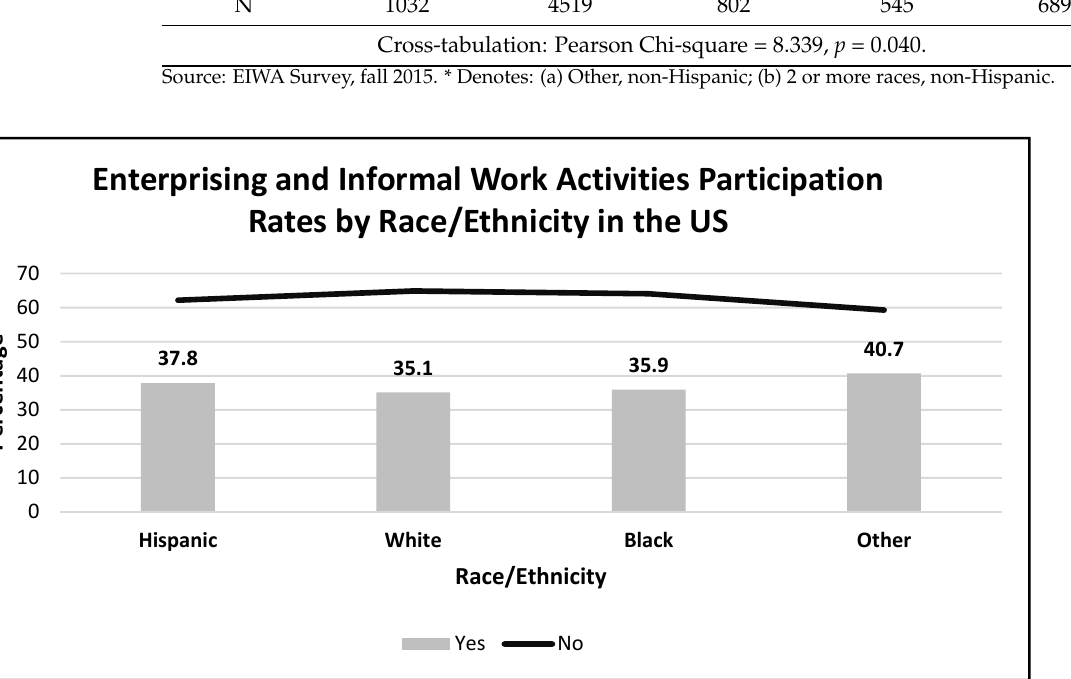
Cross-tabulation: Pearson Chi-square = 8.339, p = 0.040.